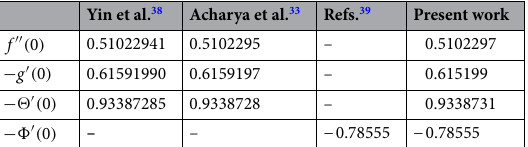
Table 2. The numerical of f ′′ ( 0 ) , − g ′ ( 0 ) , − � ′ ( 0 ) , and − � ′ ( 0 ) , when φ 1 = φ 2 = 0.5, Pr = 6.2, N = 0.5 and M = 2.0.